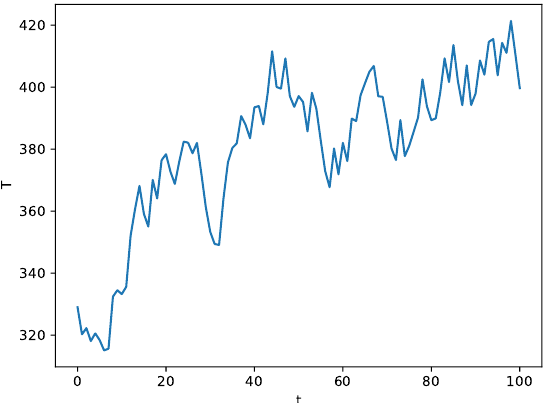
Figure 10. A result of smoothed simulation for 50k